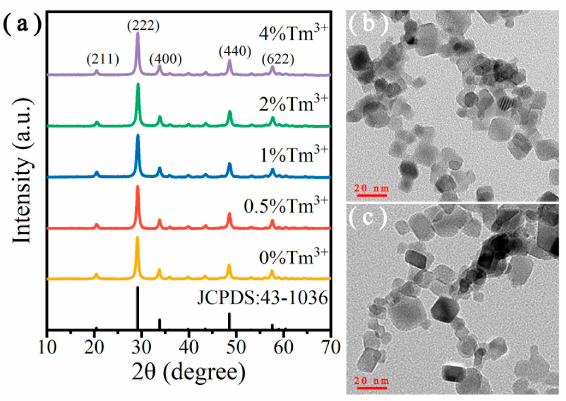
Figure 2. ( a ) XRD patterns of Y 2 O 3 :Er 3 + / Tm 3 + (8 / x mol%) upconversion nanoparticles (UCNPs). TEM images of ( b ) Y 2 O 3 :Er 3 + (8 mol%) and ( c ) Y 2 O 3 :Er 3 + / Tm 3 + (8 / 1 mol%) UCNPs.